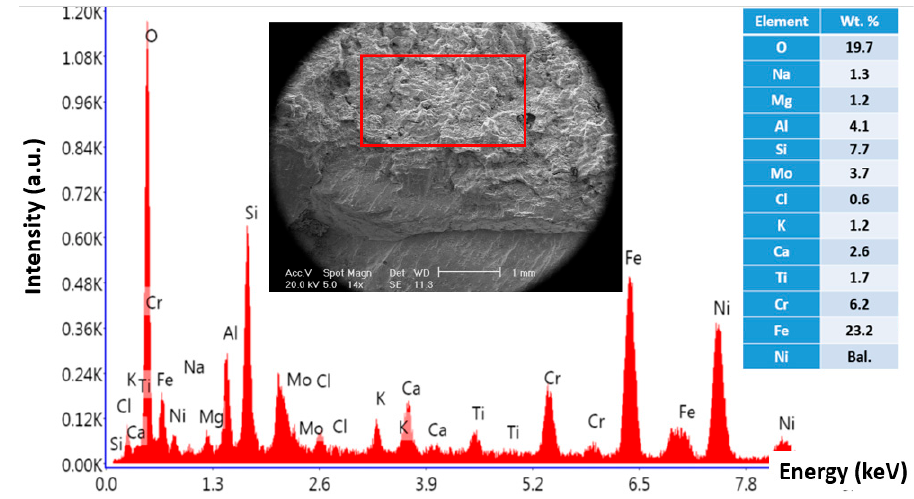
Figure 4. Energy dispersive X-ray spectroscopy (EDS) analysis of corrosion products at the edge of broken blade.